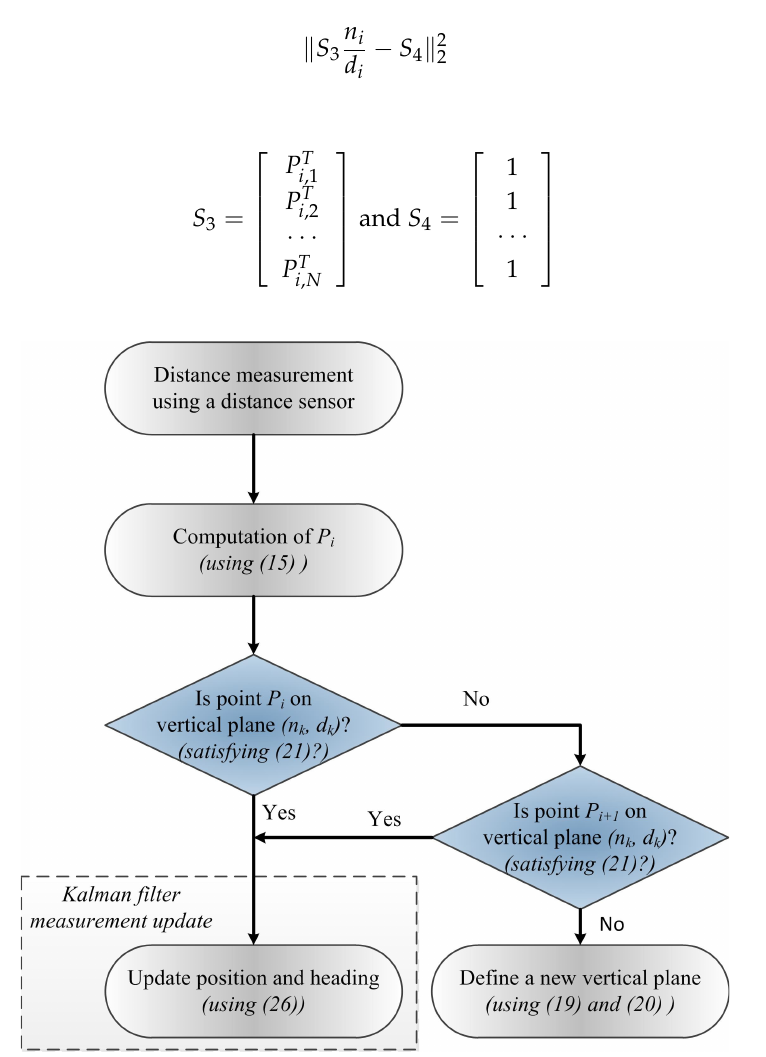
Figure 4. Proposed position and heading updating algorithm using the distance